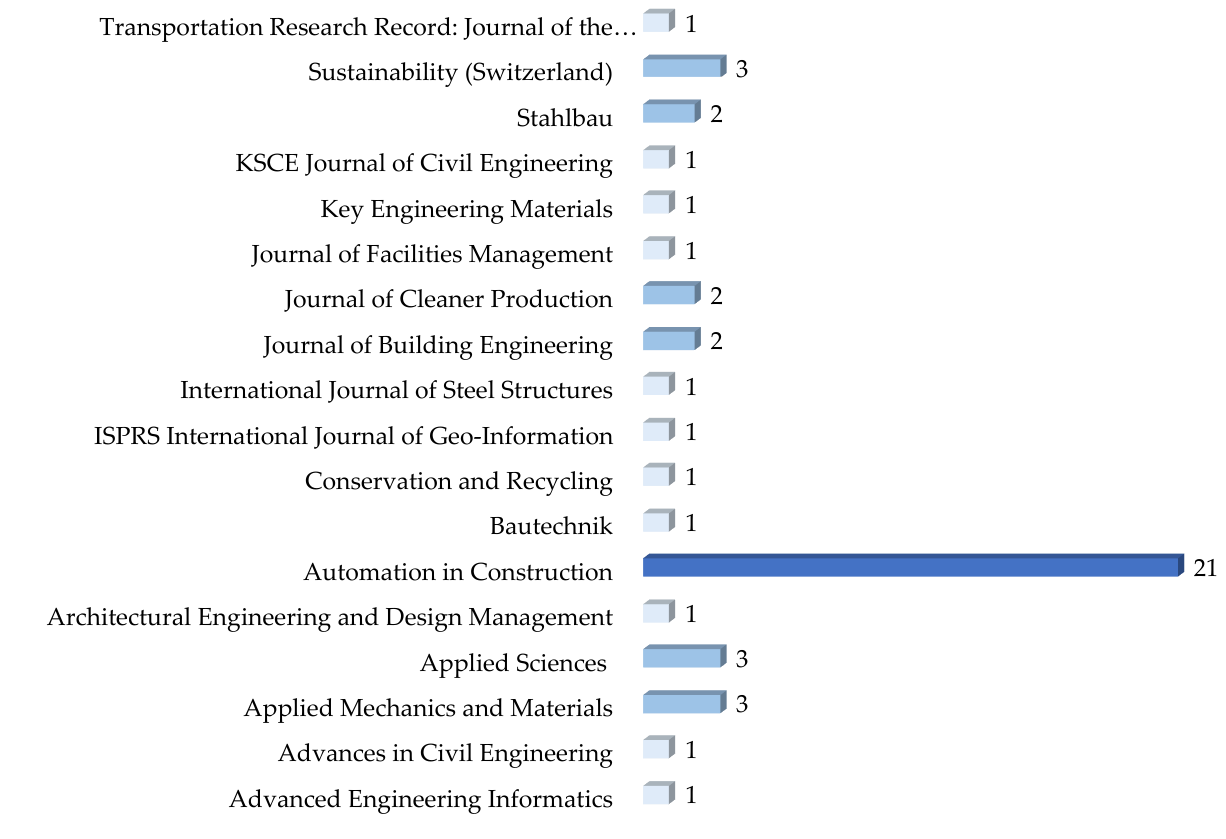
Figure 4. Number of publications per journal.